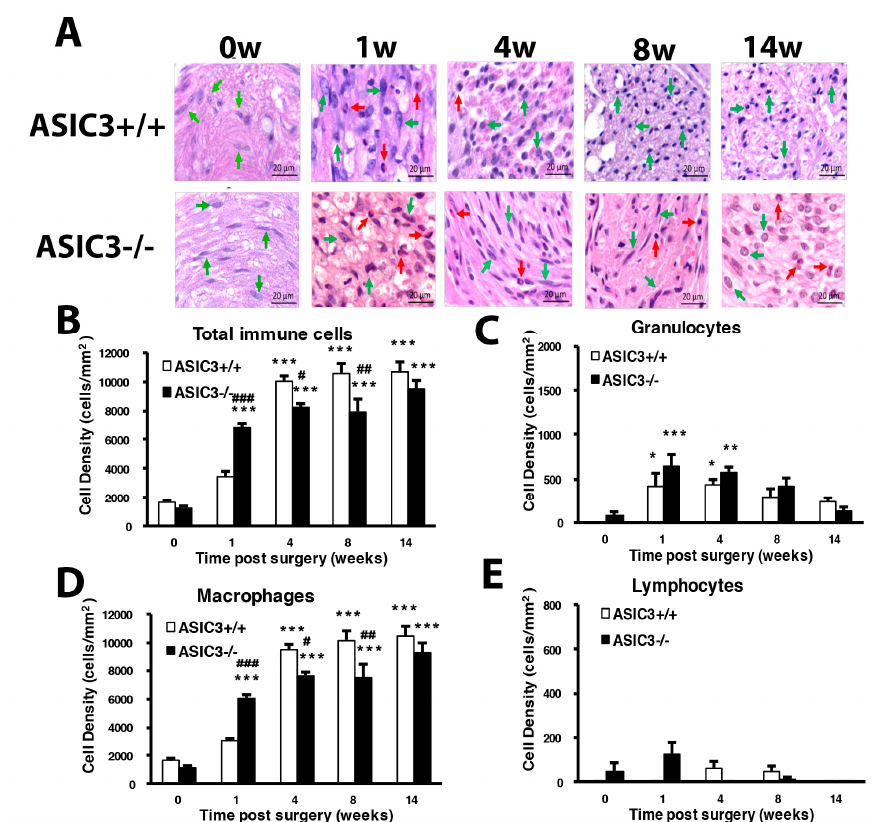
Figure 8. Mice lacking ASIC3 gene induce alteration of number of immune cells. The sciatic nerves from the ipsilateral side of ASIC3 +/+ or ASIC3 − / − mice were excised before (0 w) or at 1, 4, 8, 14 w after CCI surgery, then fixed and cross-sectioned, followed by H and E staining. Representative H and E-stained sections showing infiltration of immune cells in the sciatic nerve ( A ). Scale bar is 20 μ m. Histograms show the cell density of total immune cells ( B ), granulocytes ( C ), macrophages ( D ), and lymphocytes ( E ). Total cell number was calculated from regions of 1 mm 2 to obtain cell density (n = 3 mice). # p < 0.05; ## p < 0.01; ### p < 0.001 for ASIC3 − / − vs. ASIC3 +/+ by two-way ANOVA with post-hoc Bonferroni test.